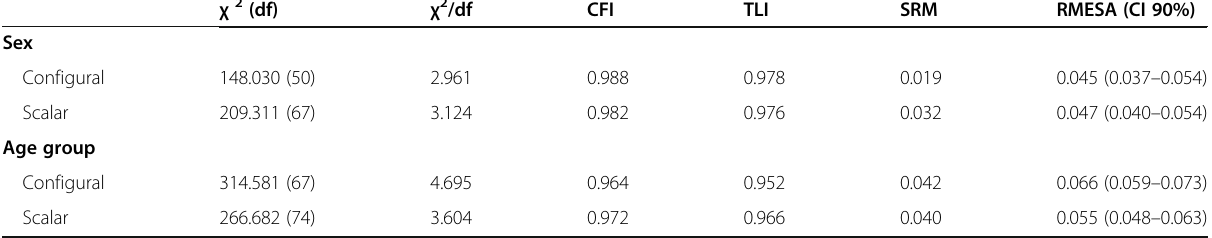
Table 3 CFA multigroup goodness-of-fit indices for the K10 as a function of sex and age group χ 2 (df)